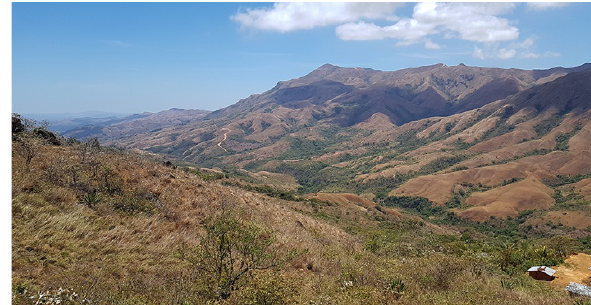
Figure 16. Savannah environment of Piedra Grande (Buglé).